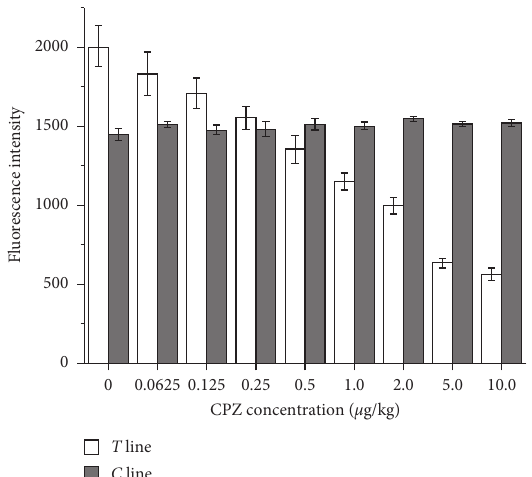
Figure 3: Fluorescence intensity of nanosphere-based time-resolved fluorescence immunoassay with 0, 0.0625, 0.125, 0.25, 0.5, 1.0, 2.0, 5.0, and 10.0 μ g/kg of chlorpromazine (CPZ). The x -axis is the fluorescence intensity on the T line and C line peaks at different CPZ con- centrations; the y -axis is a standard solution at different concentrations.